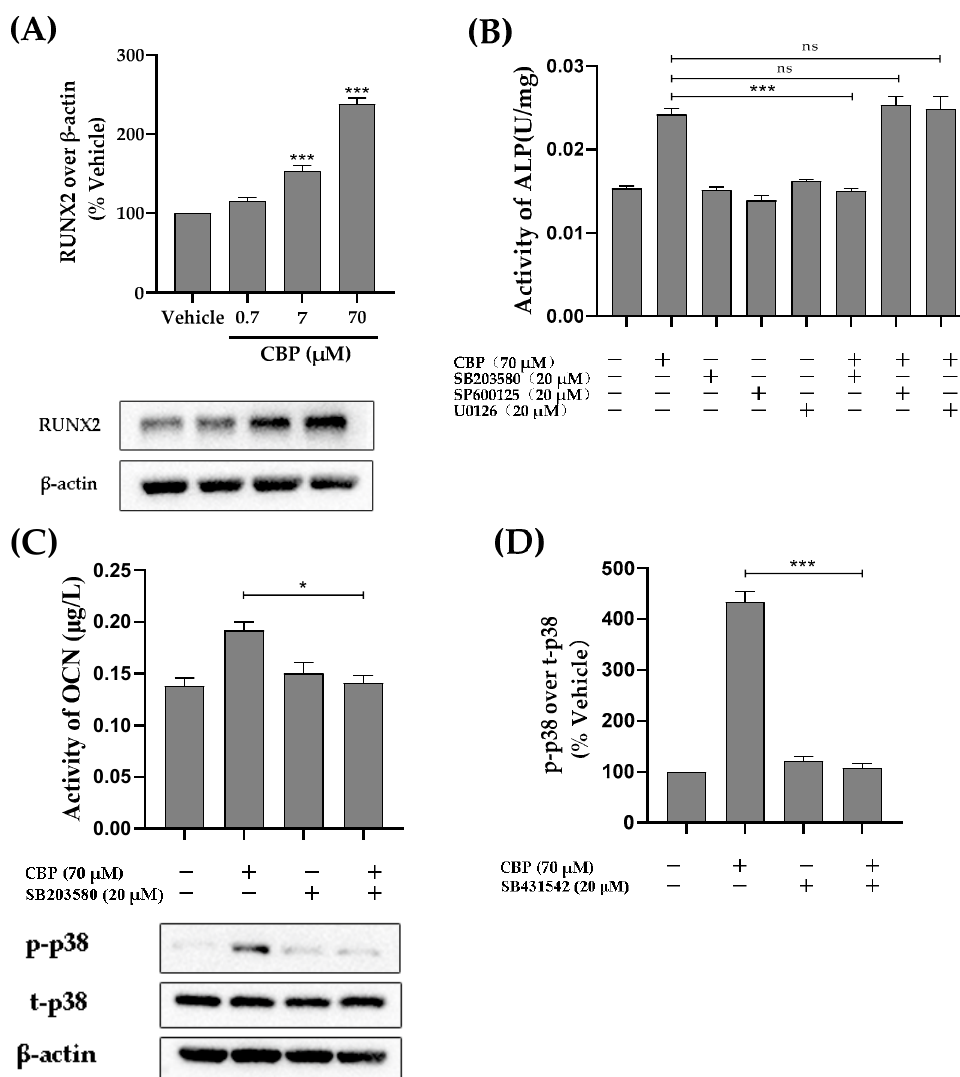
Figure 5. CBP promotes osteoblastic differentiation through the p38-MAPK mediation of the RUNX2 pathway. ( A ) CBP treatment (0.7, 7, 70 μ M) for 24 h raises the expression of RUNX2. ( B ) Effect of MAPK inhibitor (SB203580, SP600125, and U0126) (+) and culture medium ( − ) on CBP treatment (70 μ M) for 24 h increases ALP activity in MC3T3-E1. ( C ) Effect of p38 pathway inhibitor (SB203580) (+) and culture medium ( − ) on CBP treatment (70 μ M) for 24 h raises OCN concentration in MC3T3-E1. ( D ) Phosphorylation level of p38 signaling pathway in MC3T3-E1 cells cultured to 70 μ M CBP and with (+)T β RI inhibitor (SB431542) or without ( − )T β RI inhibitor (SB431542) for 3 h. n = 3. Data are expressed as mean ± SE. * p < 0.05, *** p < 0.001, ns, not significant.